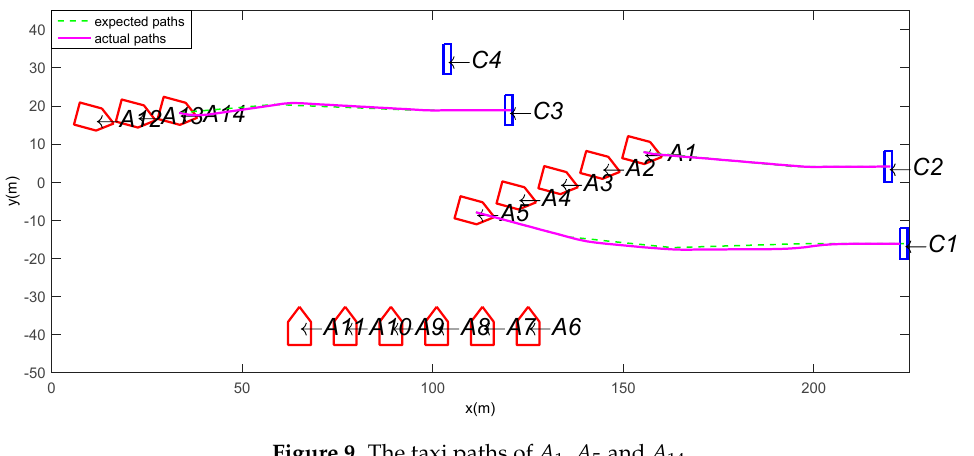
Figure 9. The taxi paths of A 1 , A 5 and A 14.